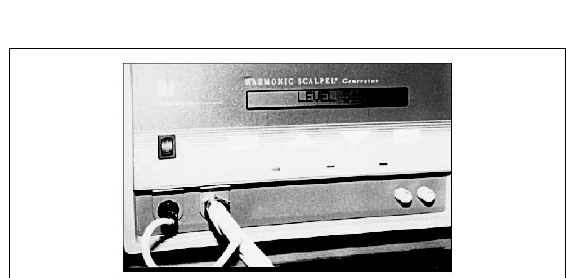
Fig. 1 – Foto do sistema UltraCision ® . Bisturi de ultra-som utilizado para tratamento intra-operatório da FAC.